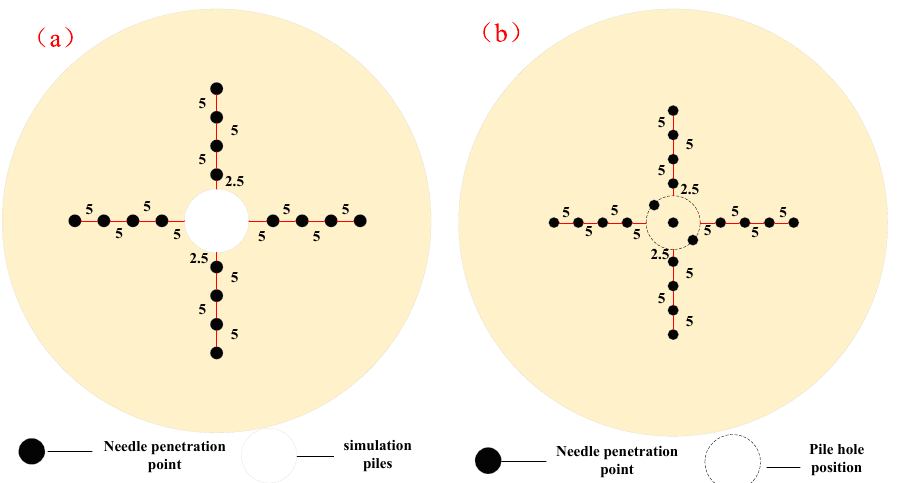
Figure 5. Schematic diagram of penetration point (unit: mm): ( a ) Section within pile body; ( b ) Section